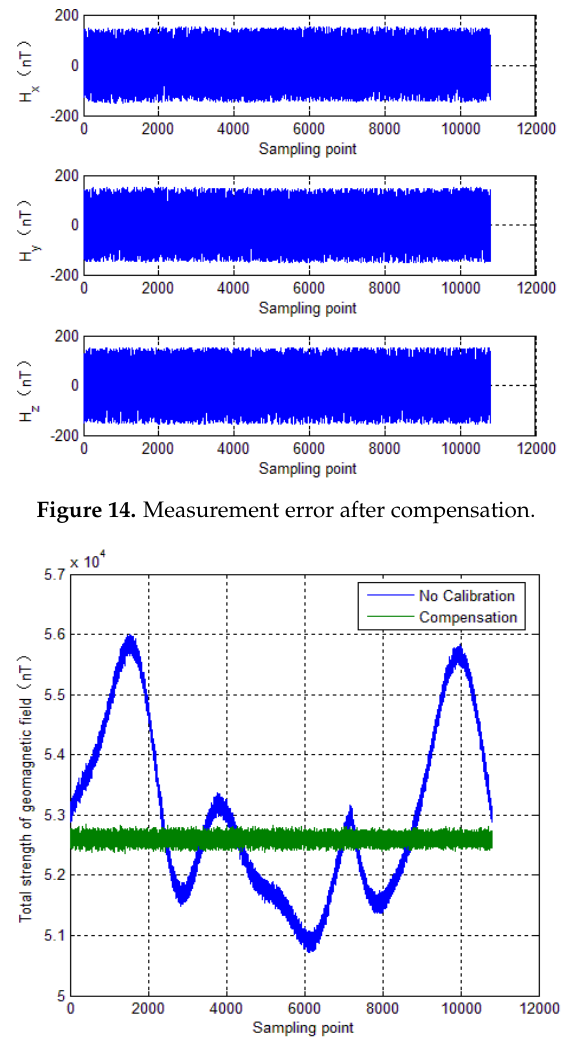
Figure 15. Total intensity of the magnetic field.